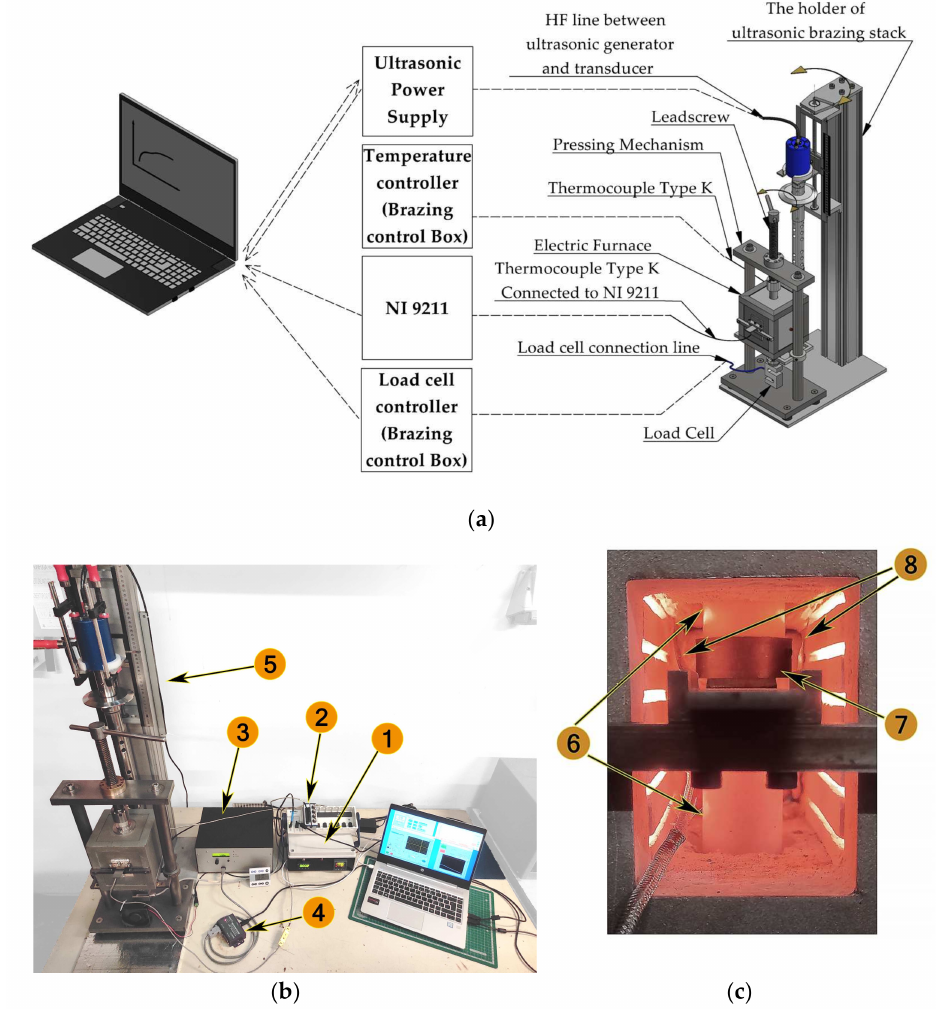
Figure 4. ( a ) Schematic diagram of ultrasonic brazing device showing signal flows between PC and the ultrasonic brazing equipment through the related peripherals; ( b ) The actual equipment assembly including: 1- brazing control box which contains furnace temperature controller and load cell controller, 2- the NI 9211 input module (14 S/s, 4 channels), 3- the ultrasonic power supply (MP Interconsulting, Switzerland), 4- the RS485-USB convertor between ultrasonic power supply and PC, and 5- the ultrasonic brazing stack with holder; ( c ) The position of the sample inside the furnace where: 6- the ceramic pivots, 7- the upper titanium end cup, 8- two thin metallic foils to protect the furnace coils from the liquid metal splashing/sputtering, brazing assembly is enclosed between the upper and the lower ends cups (Further details are shown in Figure 8a). All furnace sides were closed during the operation as it is shown in